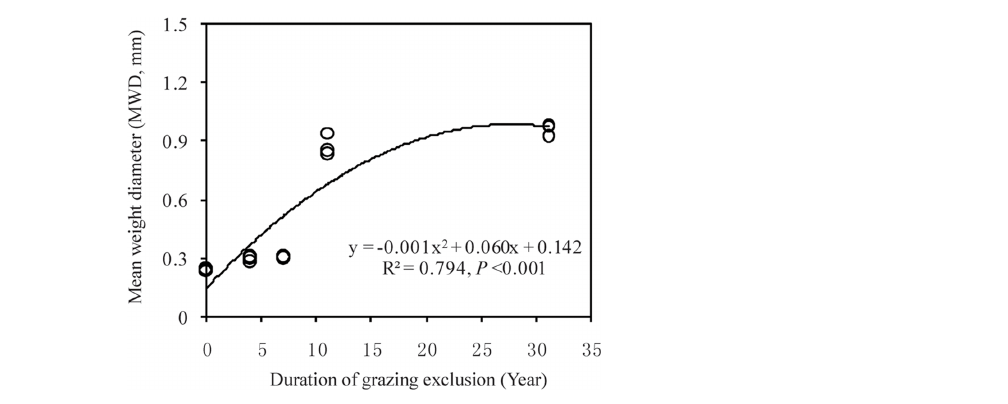
Fig 3. Changes in mean weight diameter with grazing-exclusion duration in the Inner Mongolian grasslands.